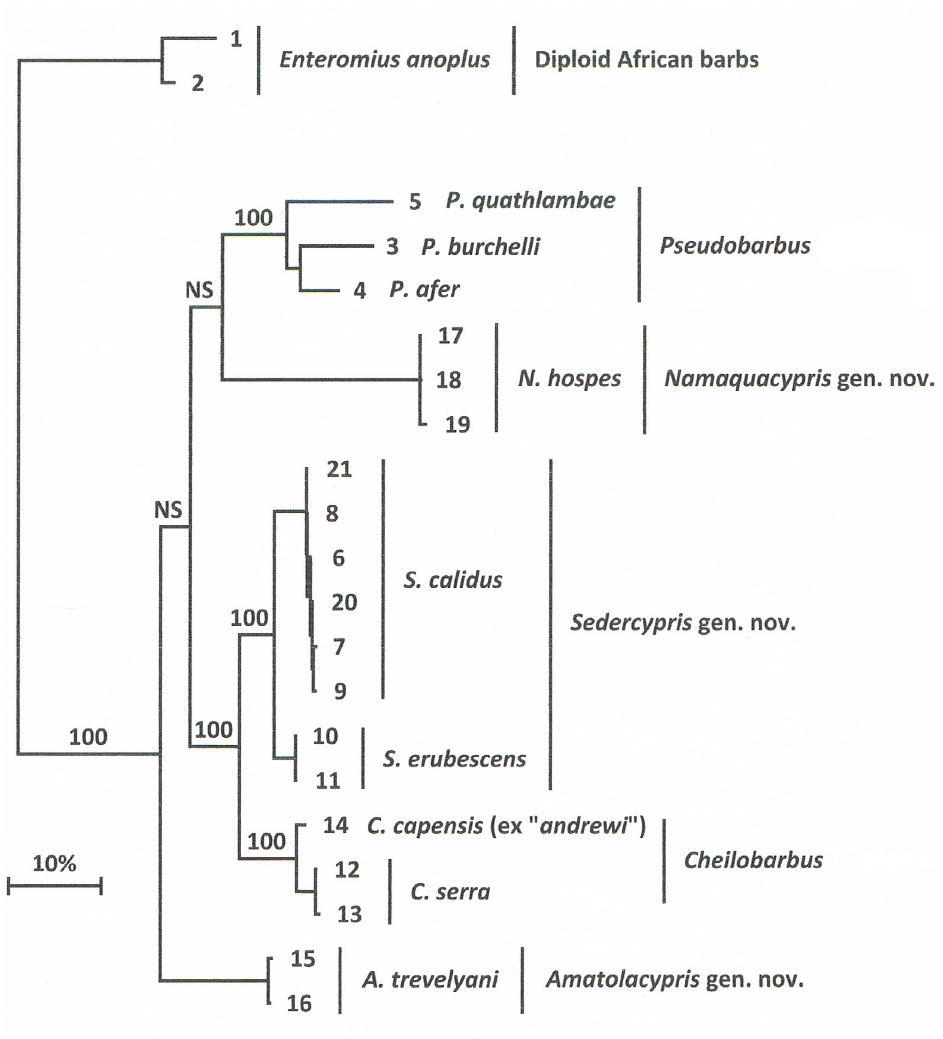
Fig. 5. Bayesian phylogram, showing the phylogenetic relationships among southern African tetraploid barbs based on the mitochondrial cytochrome b gene. Bayesian posterior probabilities are shown above branches. Allele codes are indicated at terminal branches. NS: Not significant. The Bayesian posterior probability at higher NS node is 53%; at the subsequent node